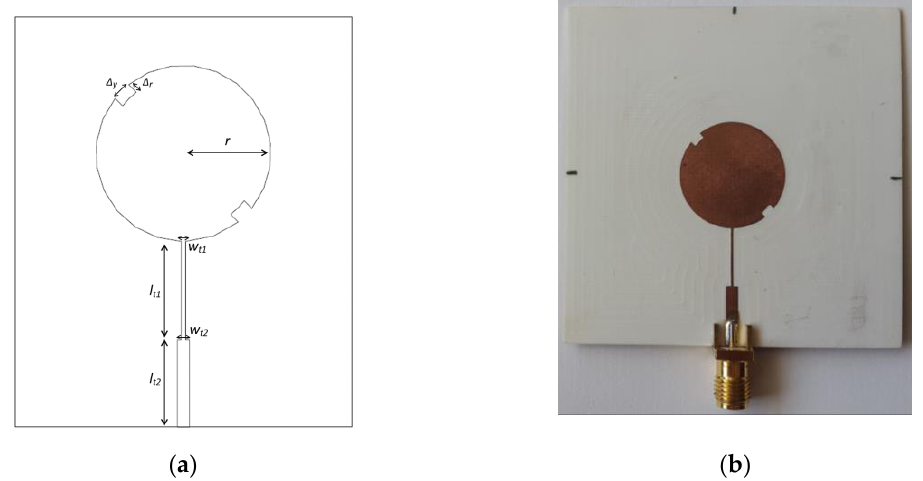
Figure 2. Microstrip patch element: ( a ) structure and dimensions; ( b ) photograph of the prototype. The dimensions of the microstrip element designed for 5.8 GHz are: r = 9.1 mm, Δ y = 2 mm, Δ r = 1.1 mm, l t1 = 10.2 mm, w t1 = 0.45 mm, l t2 = 9 mm, and w t2 = 1.25 mm. The circular patch element